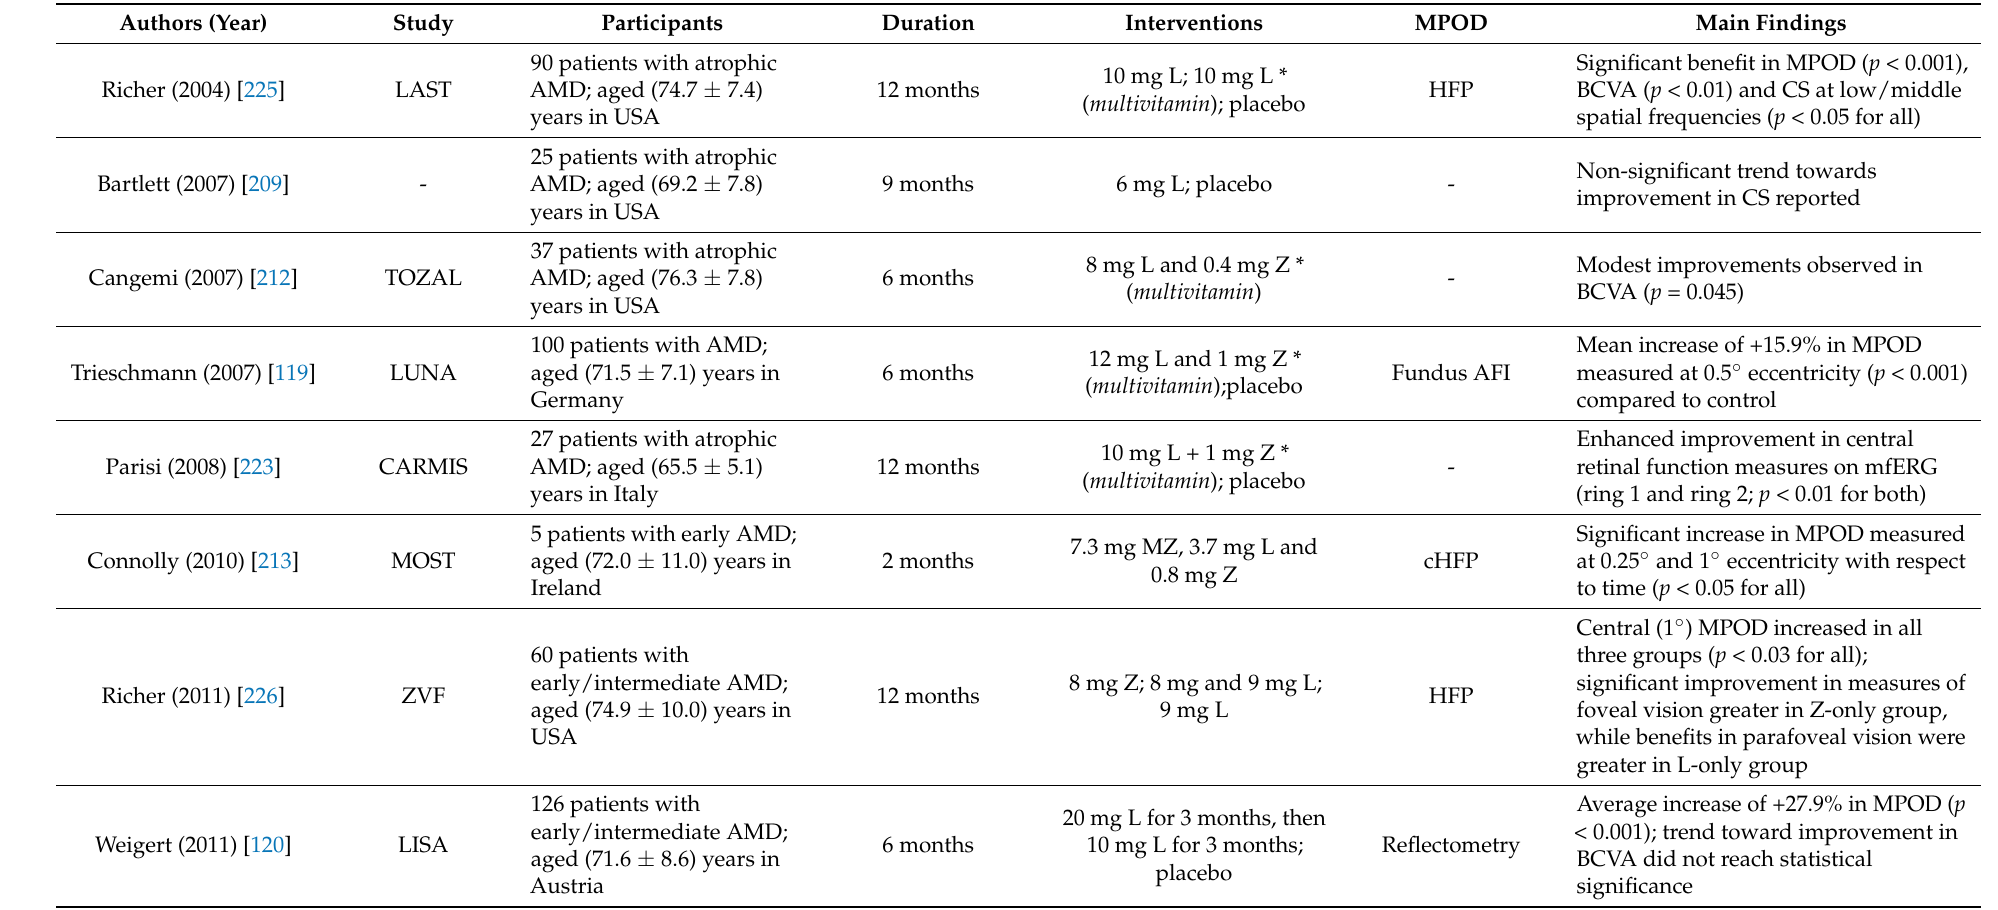
Table 5. A summary of the eligible randomized clinical trials reporting on